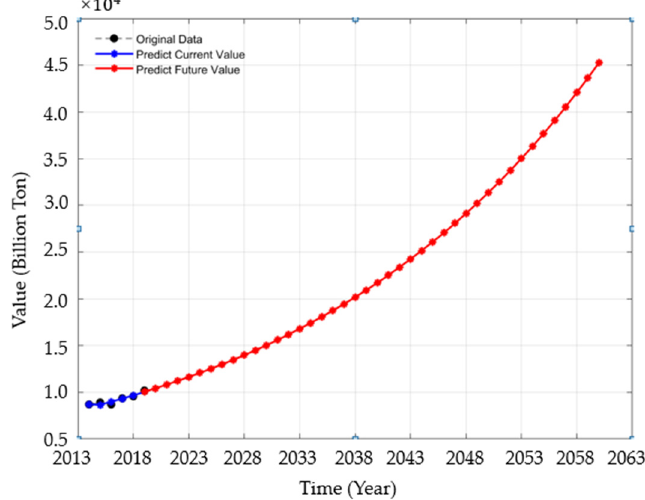
Figure 2. Forecast data of China’s CO 2 emissions from 2020 to 2060 by GM (1, 1)